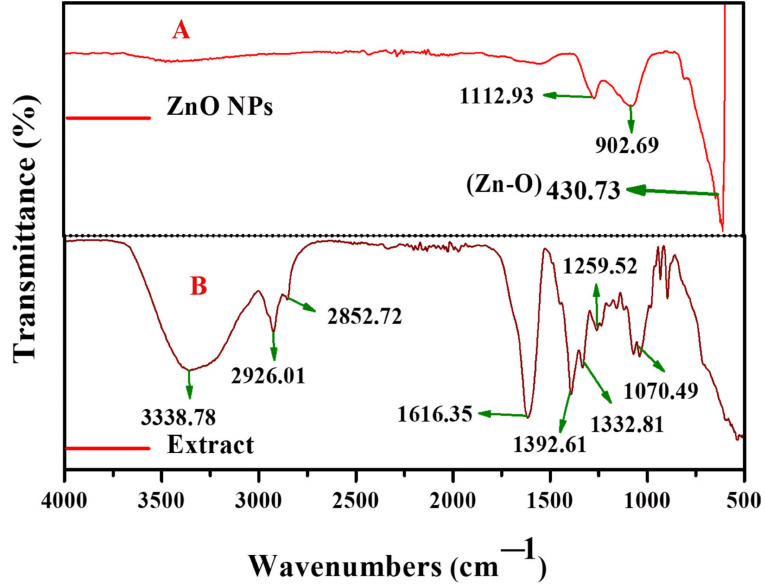
Figure 4. FT-IR spectroscopy of ZnO nanoparticles ( A ) and sunflower leaf extract ( B